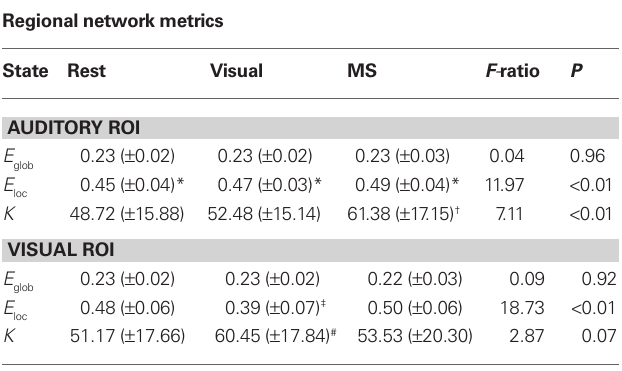
Table 3 | Auditory and visual rOi metric assessment.